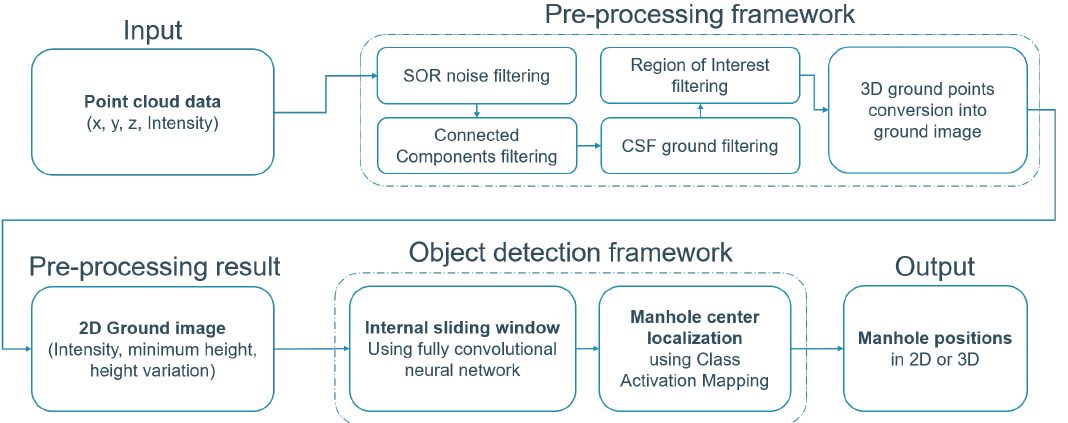
Figure 1. Schematic overview of the proposed method with the preprocessing and the object detection framework. The former filters and converts the mobile mapping point cloud into a 2D ground image. This image is then used by latter to detect the different manhole covers and locate them accurately.